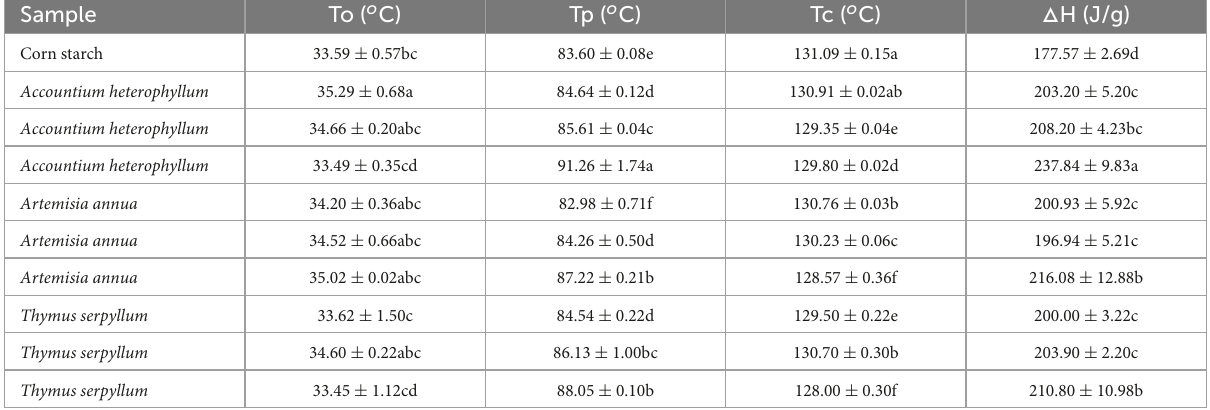
TABLE 5 Effects of different medicinal plants reinforced films on endothermic curves of starch-based